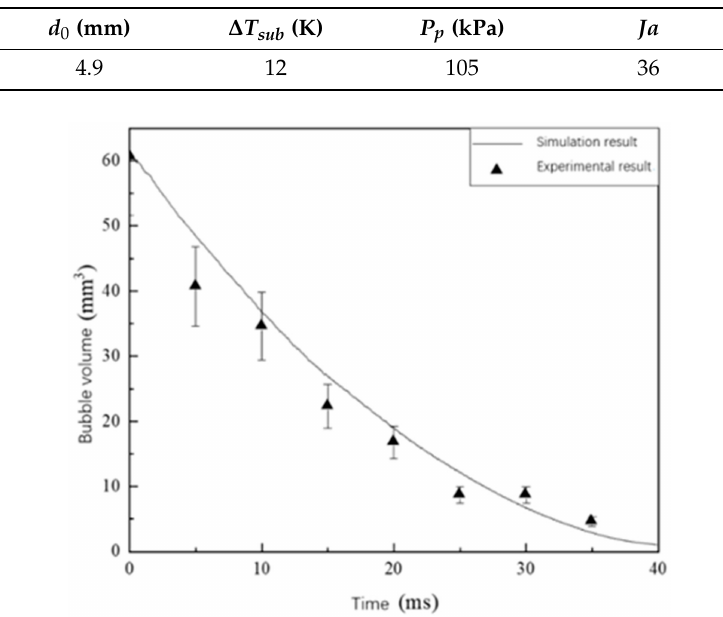
Table 2. Experimental conditions [6].